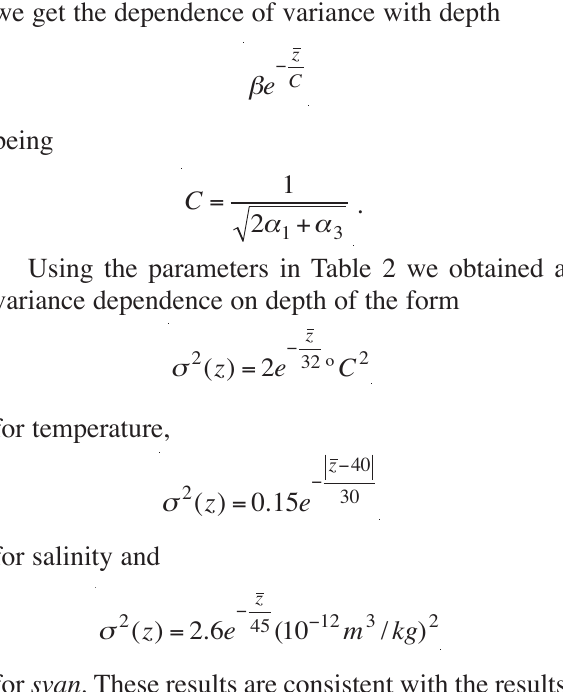
F IG . 6. – Solid lines are isolines of constant covariance for pairs of points with the same horizontal coordinate and different depths. Calculations were made for the most offshore stations (P3, M3 and V3) and then averaged. Dashed lines are the fit using a function cov( , . Values of the different parameters can be seen in Table 2. svan values are multiplied by 10 12 . 444 M. VARGAS-YÁÑEZ et al.